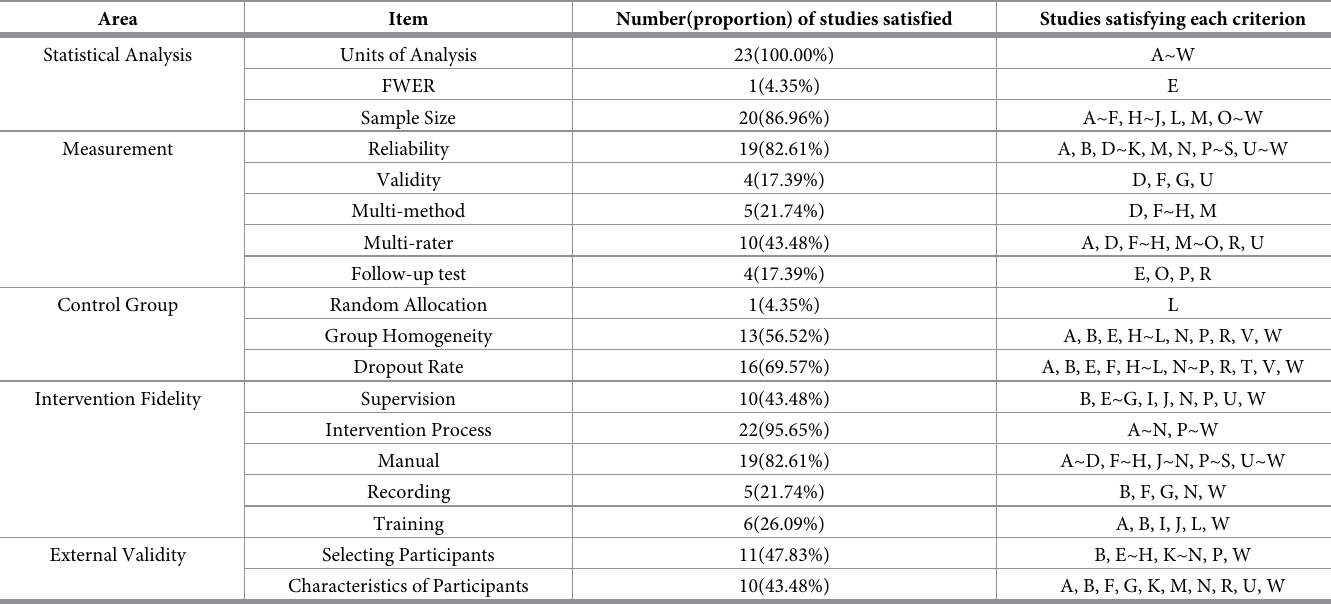
Table 3. A quality analysis on selected